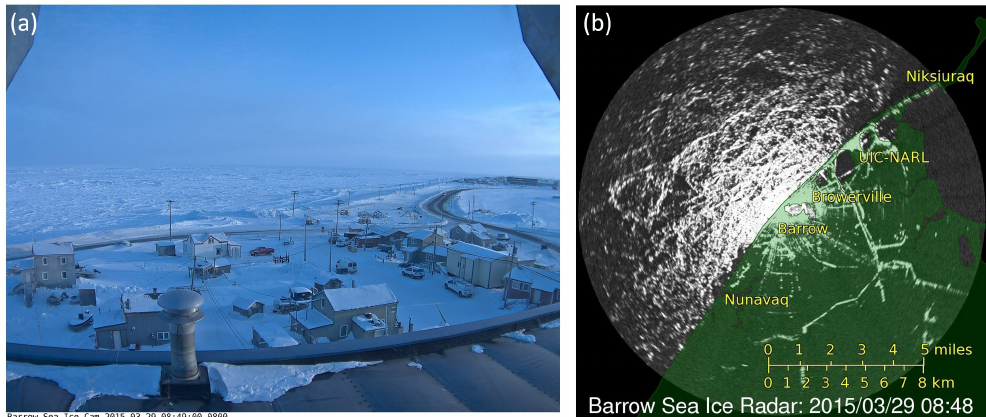
Figure 3. Webcam (a) and sea ice radar image (b) obtained from the Geographic Information Network of Alaska, University of Alaska Fairbanks, taken 29 March 2015